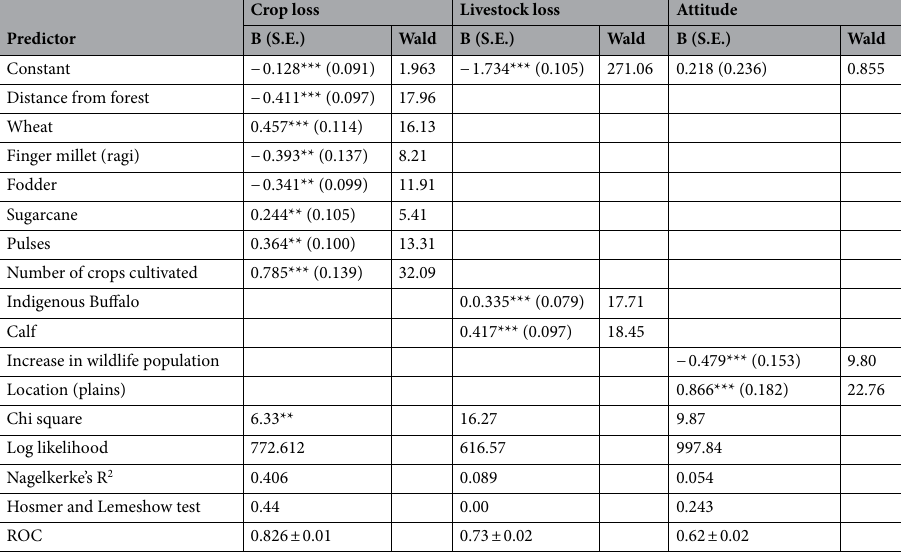
Table 4. Coefficients (β) for predicting crop damage, livestock depredation and positive attitude of local communities towards wildlife around the forest corridor linking the Rajaji and Corbett Tiger Reserves, Uttarakhand, India. *, ** and *** indicate significance at levels of 0.5, 0.01 and 0.001, respectively.